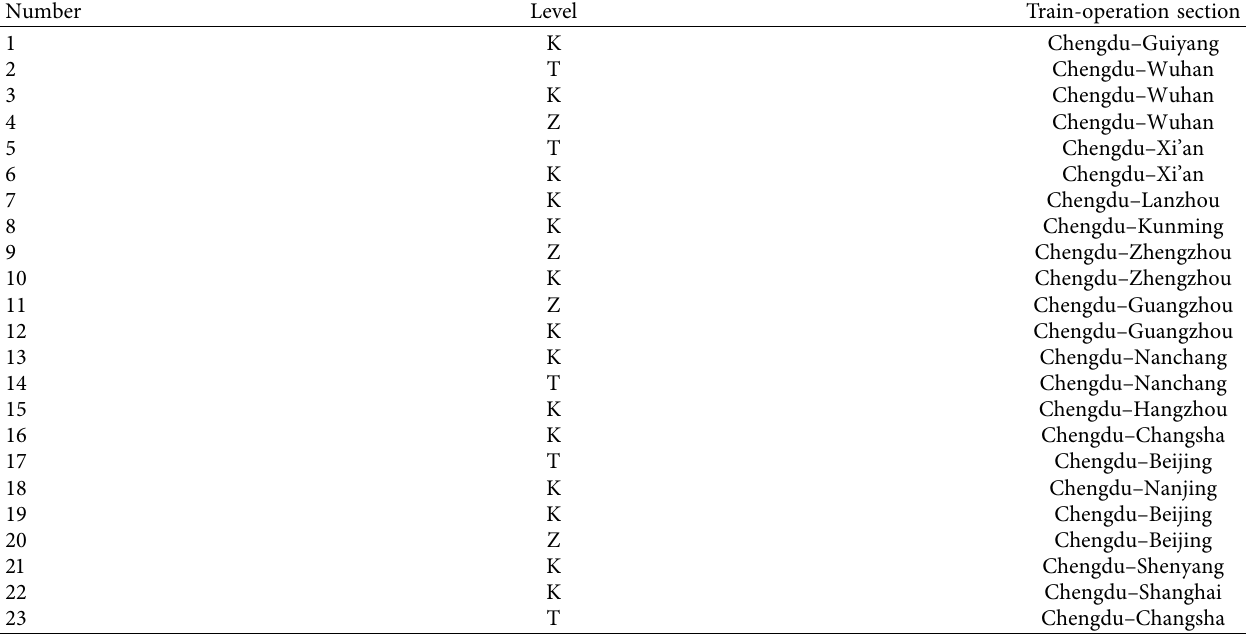
Table 1: 23 pairs of passenger train information with Chengdu as the starting/terminal station. Number Level